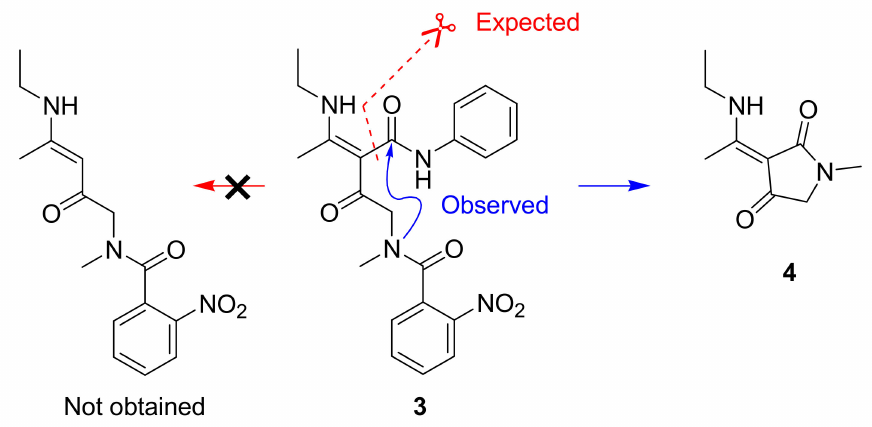
Table 1. Antibacterial activity of compound 4 (R = CH 3 ) and N -alkoxycarbonyl analogs.